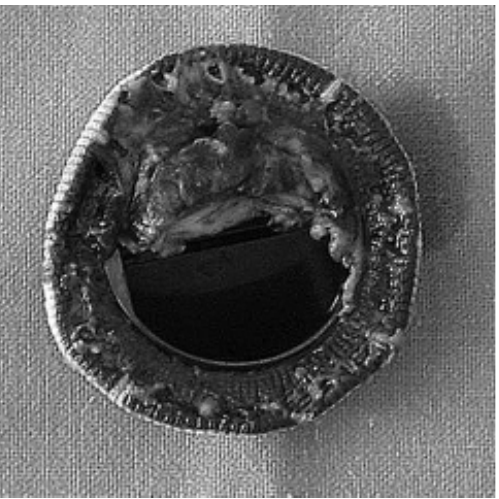
Fig. 1 - Trombose de uma prótese mecânica CarboMedics de 31 mm. Visão Anterior